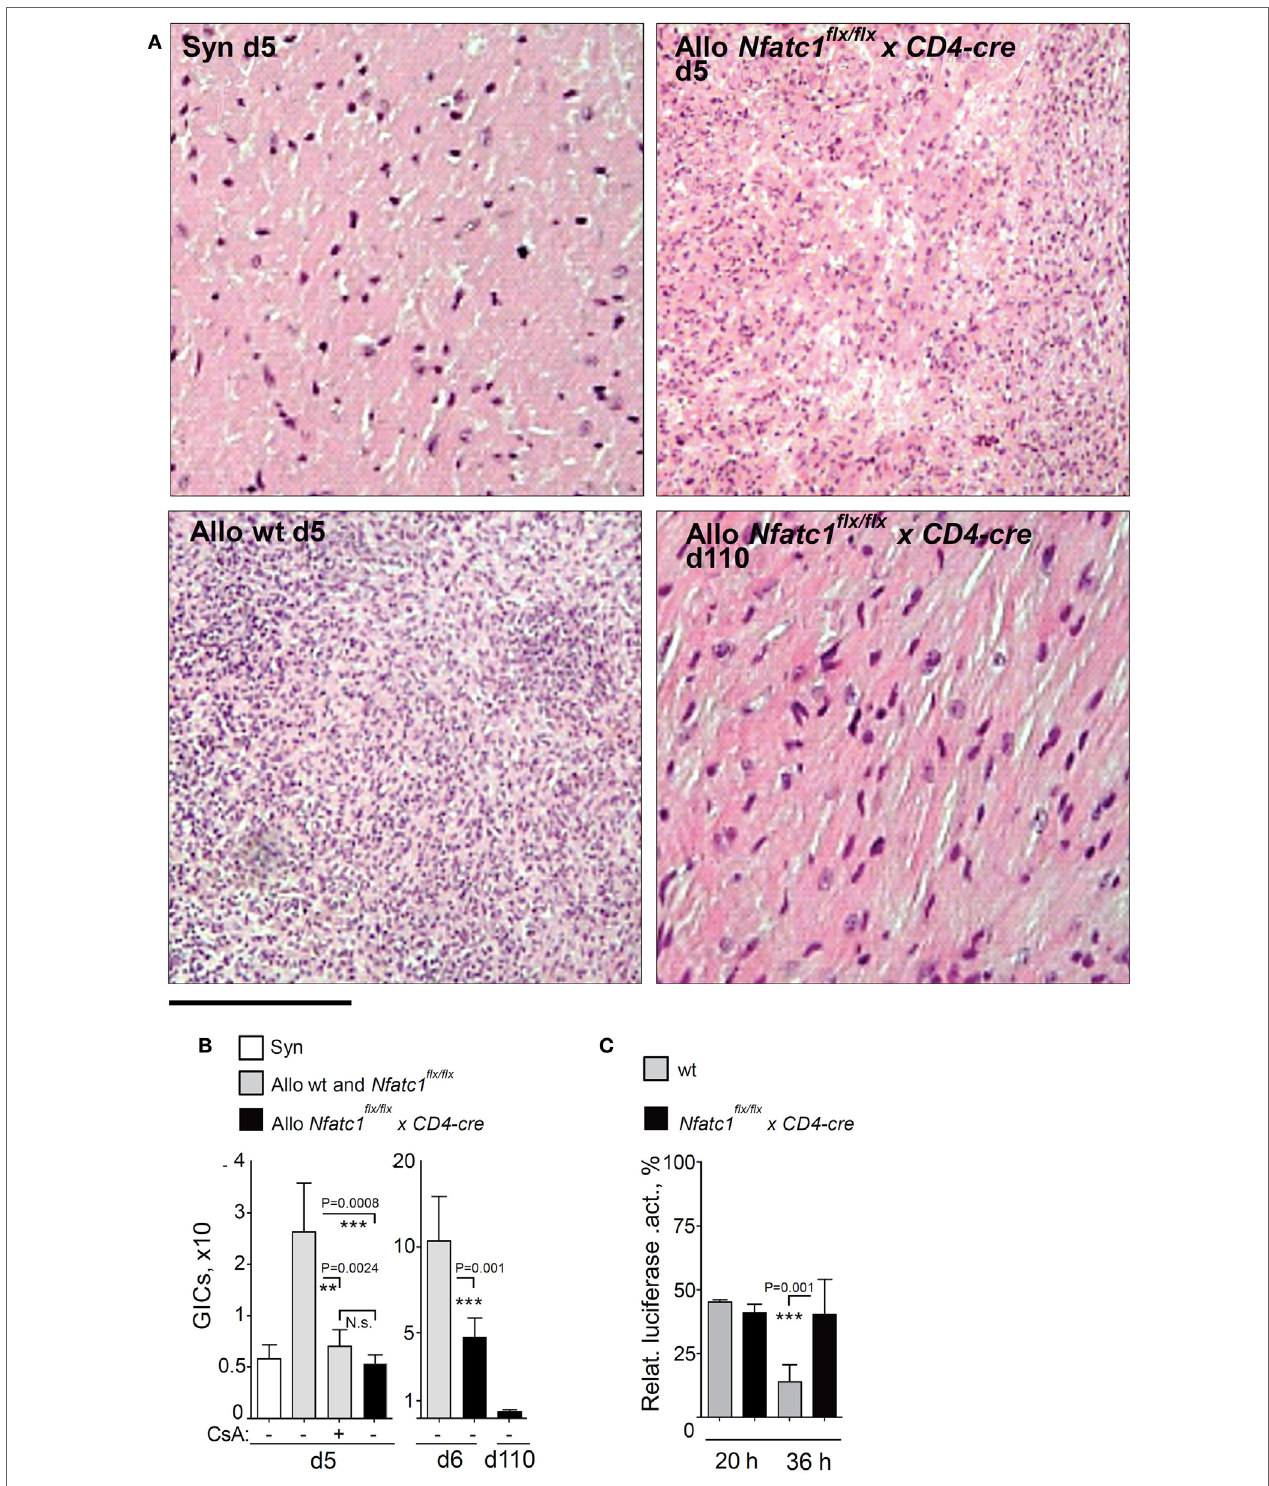
FigUre 3 | Graft-Infiltrating Cells (GICs) in transplanted hearts. (a) Representative hematoxylin–eosin stains of grafts from syngeneic and allogeneic wild-type (WT) recipients, and from Nfatc1 flx/flx x CD4-cre recipients during the acute rejection phase (d5), and from Nfatc1 flx/flx x CD4-cre recipients at d110. Bar, 300 µm. (B) Quantification of GICs in transplanted allogeneic hearts with ( + ) and without ( − ) cyclosporin A (CsA) treatment of animals. (c) Cytotoxicity of GICs. Luciferase assays were performed after cultivation of MOPC- luciferase target cells together with equal numbers of GICs isolated from WT or Nfatc1 flx/flx xCD4-cre recipient mice during the acute rejection phase (d6, effector/target ratio 4/1, followed by 20 or 36 h